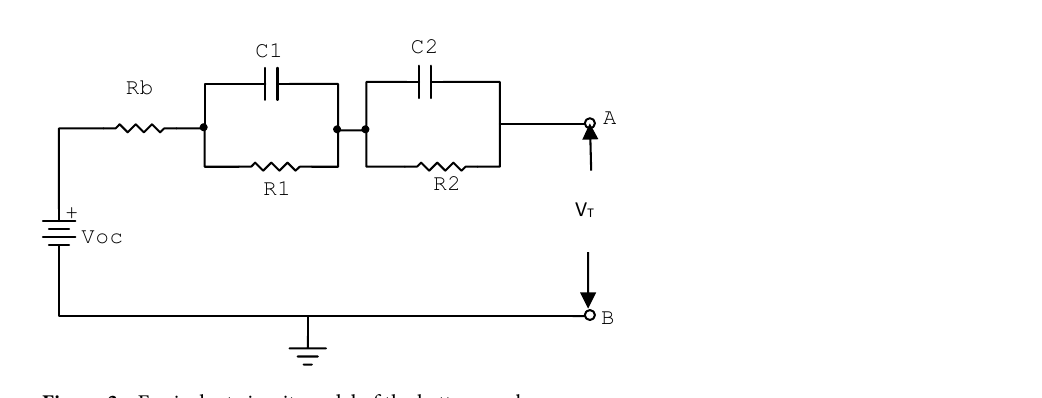
Figure 3. Equivalent circuit model of the battery